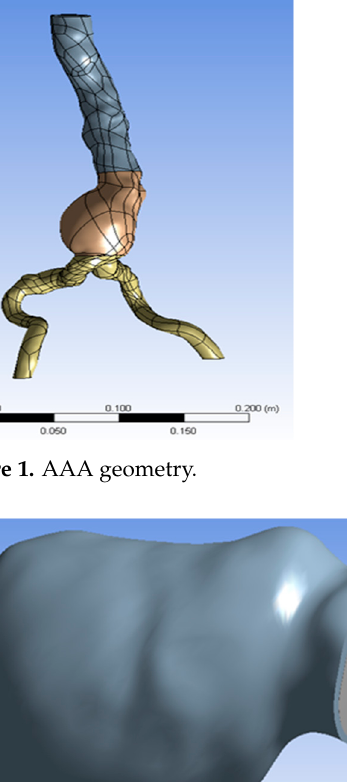
Figure 1. AAA geometry.